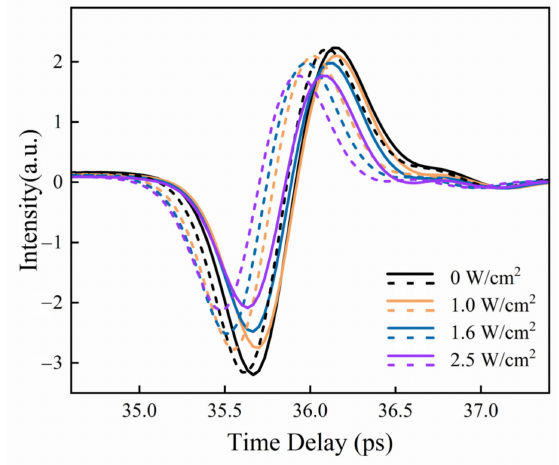
Figure 4. Time-domain transmission terahertz signals of PtSe 2 devices at different pump power density, where solid and dashed lines represent 3L and 6L PtSe 2 devices,